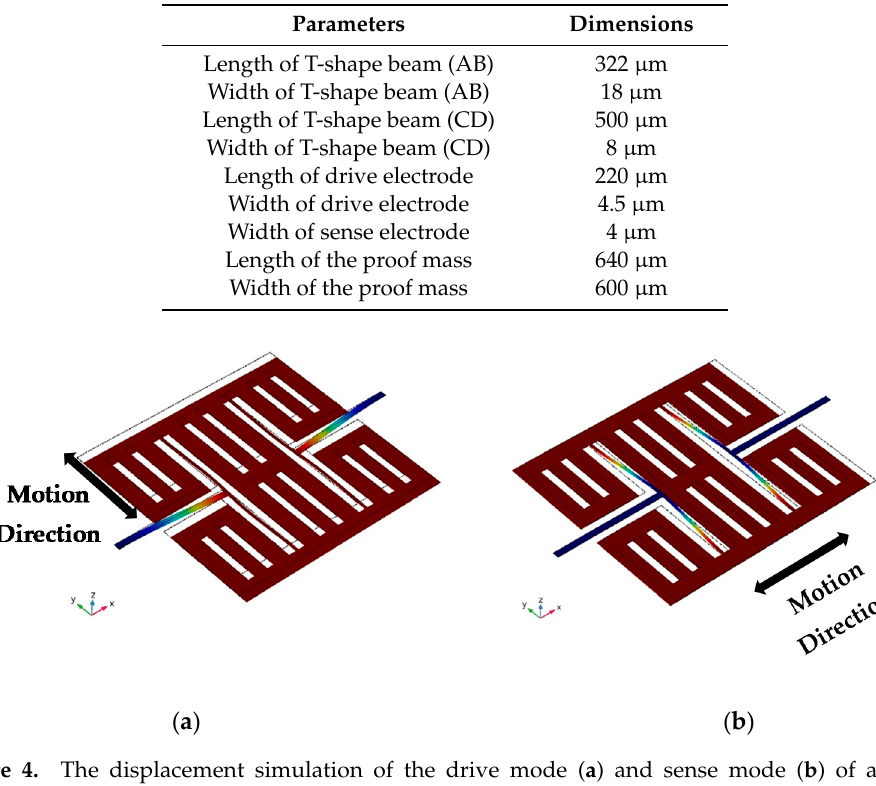
Table 1. The parameters of the MEMS gyroscope.